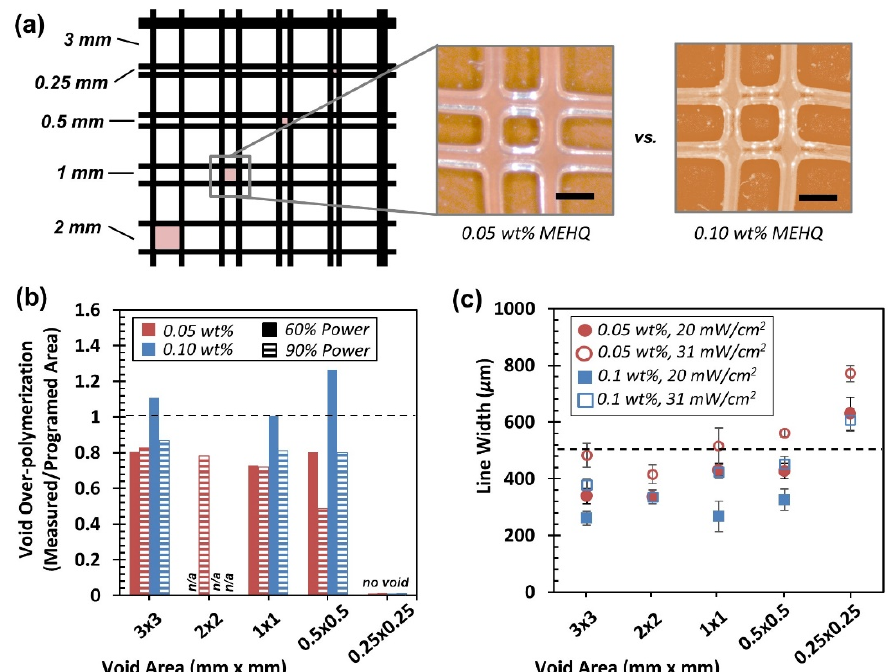
Figure 3. Optimization of SLA features via the addition of inhibitor. ( a ) Image of test structure consisting of 0.5 mm beams with varying pitch. Pictures of 1 × 1 mm 2 voids with 0.05 and 0.10 wt% MEHQ inhibitor. Scale bar corresponds to 1 mm. ( b ) Void over-polymerization as a function of MEHQ concentration and light intensity, all samples were exposed for 7 s. Over-polymerization was determined by measuring the void area of the printed sample divided by the programmed void area. ( c ) Line width measured as a function of void area, MEHQ concentration, and light intensity. Dashed line represents the programmed line width, 0.5 mm.